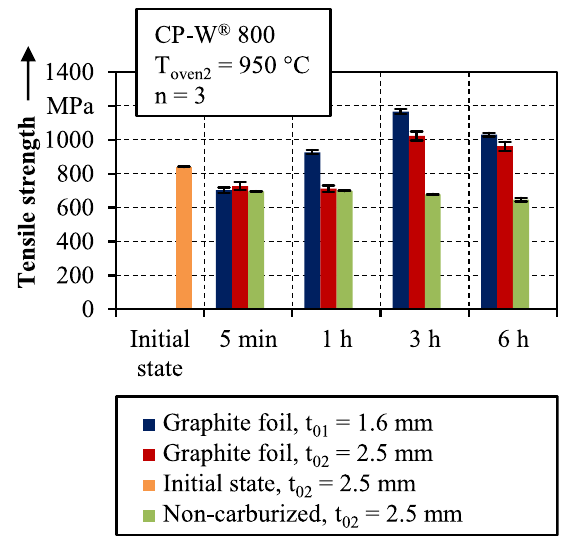
Fig. 4. Tensile strength of coated and uncoated specimens after a heat treatment at 950 °